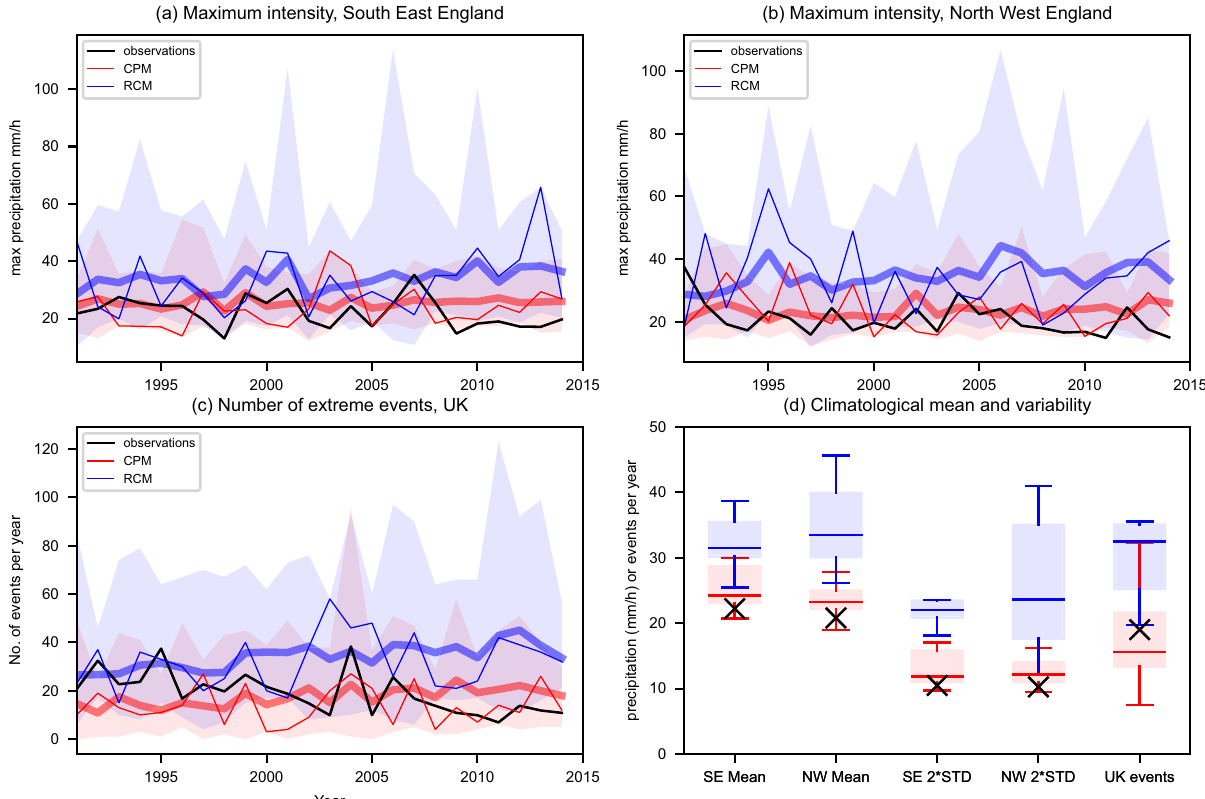
Fig. 1 | Model performance in representing extreme hourly precipitation. Regional annual maximum hourly precipitation for a South-East England and b North-West England, and c number of events per year across the UK exceeding 20mm/h. Regional annual maximum corresponds to the maximum precipitation (mm/h) occurring within the region (considering all 12km grid boxes) in a given year. Results are shown for CEHGEAR observations (black), the 2.2km convection- permittingmodel(CPM,red)and12kmregionalclimatemodel(RCM,blue)forthe standard member (thin line), ensemble-mean (thick line) and ensemble min – max